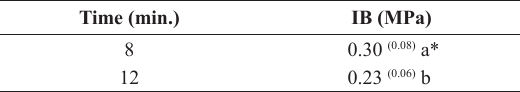
Table 11. Average values of internal bond as a function of time. Time (min.)